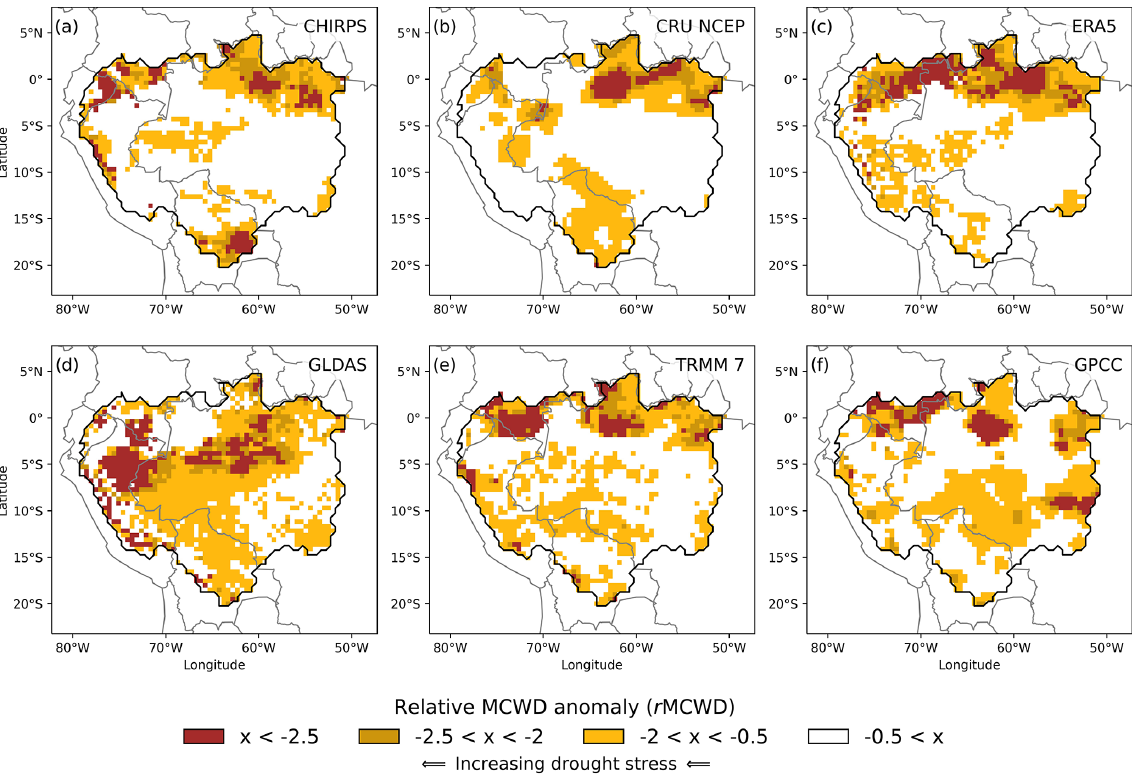
Figure 1. Relative MCWD anomalies (from October to September) as an indicator of drought stress in the Amazon basin during the record- breaking drought event in 2016. Displayed are only the datasets that include the year 2016 in their temporal range. The baseline period of the MCWD calculation is 2001 to